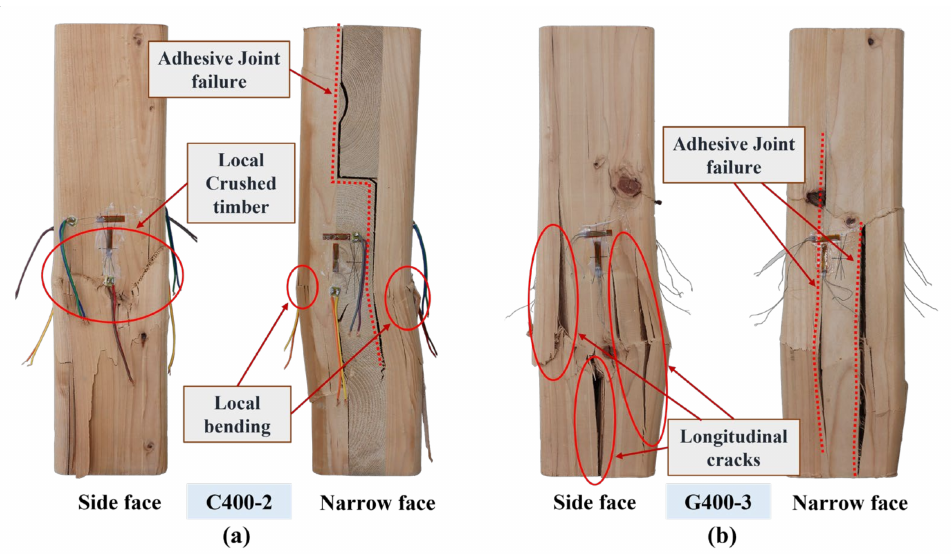
Figure 5. Typical failure modes of unconfined specimens: ( a ) C400-2; ( b )